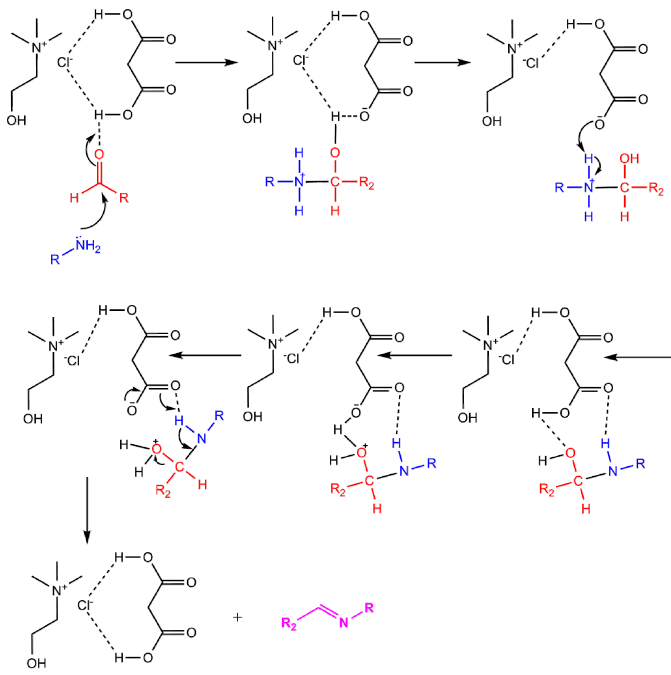
Scheme 2. Proposed mechanism for synthesis of Schiff bases in choline chloride:malonic acid (1:1)